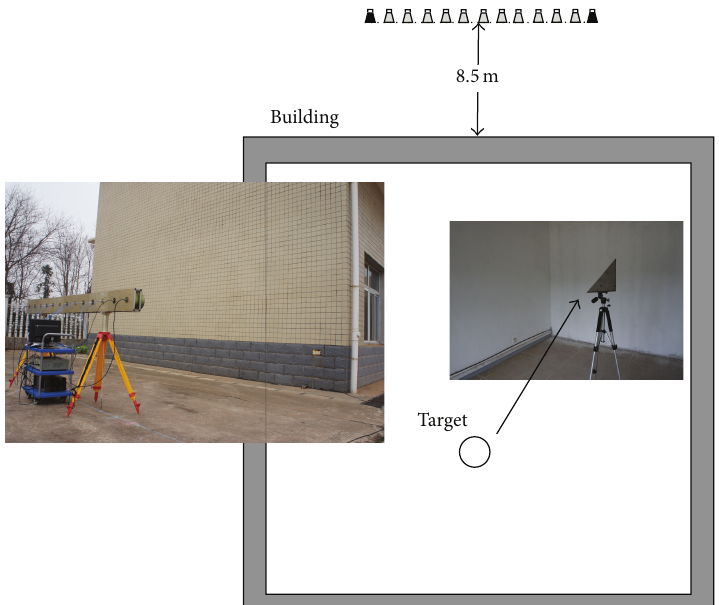
Figure 7: Data collection scenario.